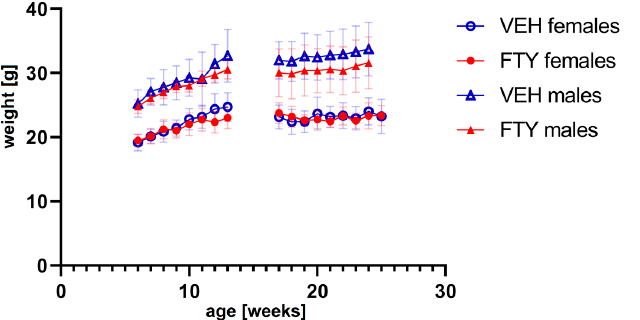
Figure 1. The graph shows the weight progression of early treated (left) and late treated animals ( right ) for all experimental groups. FTY—fingolimod (FTY720)-treated animals; VEH—vehicle- treated control animals. Data are presented as mean ± SD; n = 8 in all groups, except for the late treatment males ( n = 13). Statistical analysis was performed using two-way ANOVA (mixed-effects model). No significant differences were found.